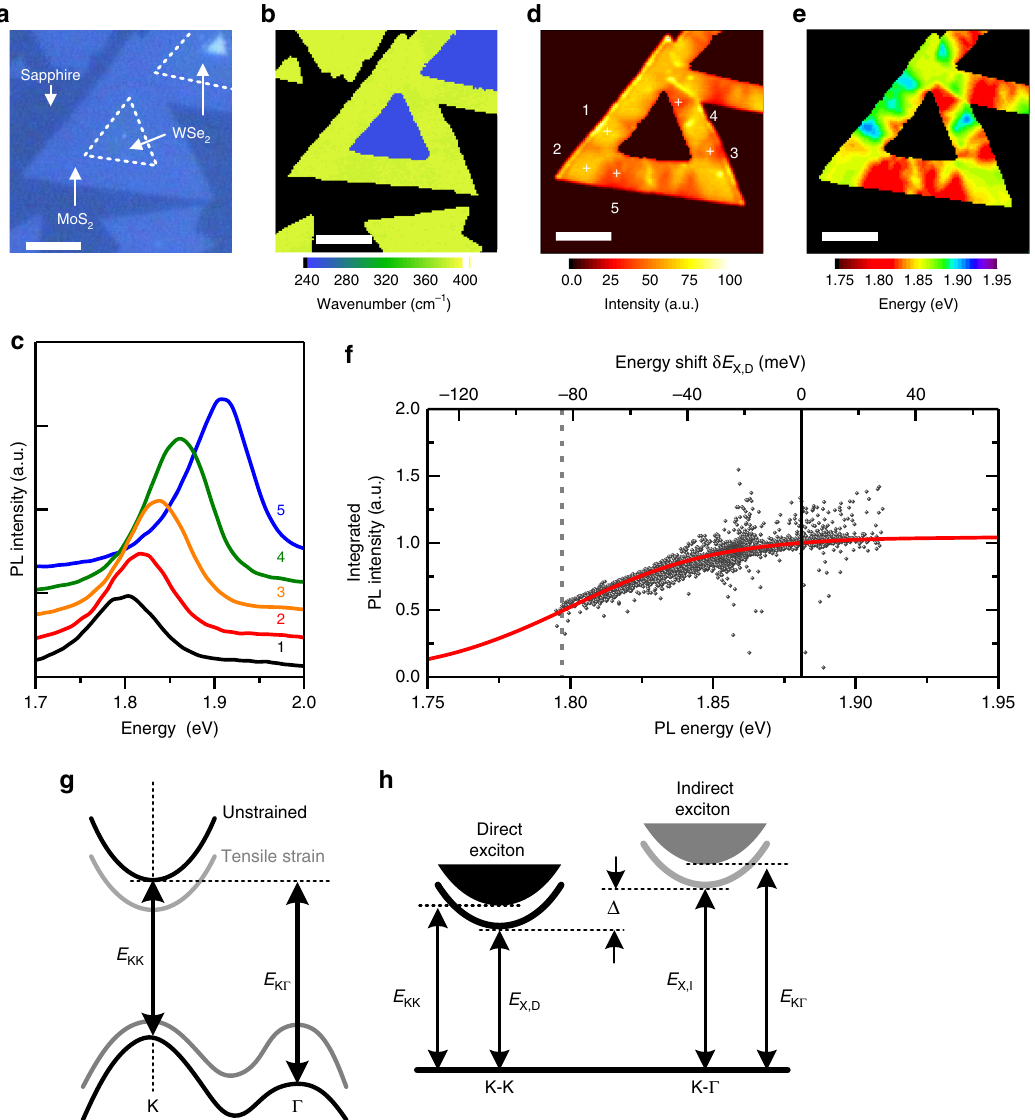
Fig. 1 PL inhomogeneity in strained WSe 2 – MoS 2 lateral HJs. a , b Optical image ( a ) and the corresponding contour color map of the E 2g Raman peak position ( b ) of a monolayer WSe 2 – MoS 2 lateral HJ fl ake. c Five selected PL spectra from different positions in the MoS 2 region. d , e Contour color maps of the PL intensity ( d ) and peak energy ( e ) of the MoS 2 region. f Integrated PL intensity as a function of peak energy obtained from all PL spectra (black dots). Solid line is the model fi tting curve. The top axis is the PL peak energy shift with respect to the unstrained MoS 2 (vertical line). g Schematics for the band structures of monolayer MoS 2 without (black) and with (gray) tensile strain. h Schematics for the direct (K-K) and indirect (K- Γ ) excitonic states with energies of E X,D and E X,I ,